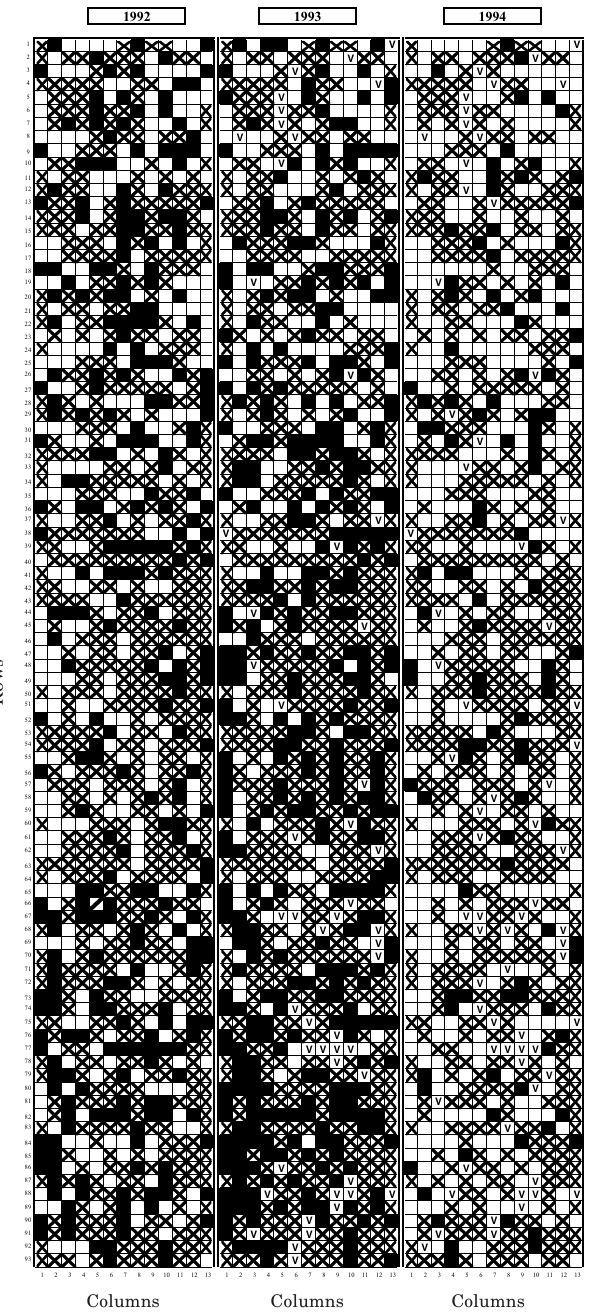
Fig. 2. Spatial pattern of esca-diseased plants in a vineyard at San Casciano Val di Pesa in the province of Florence cumulated. Black squares, symptomatic plants; open squares, asympto- matic plants; gray squares, symptomatic plants in previous years, or dead; “ X ”, plants died be- fore start of survey (cause